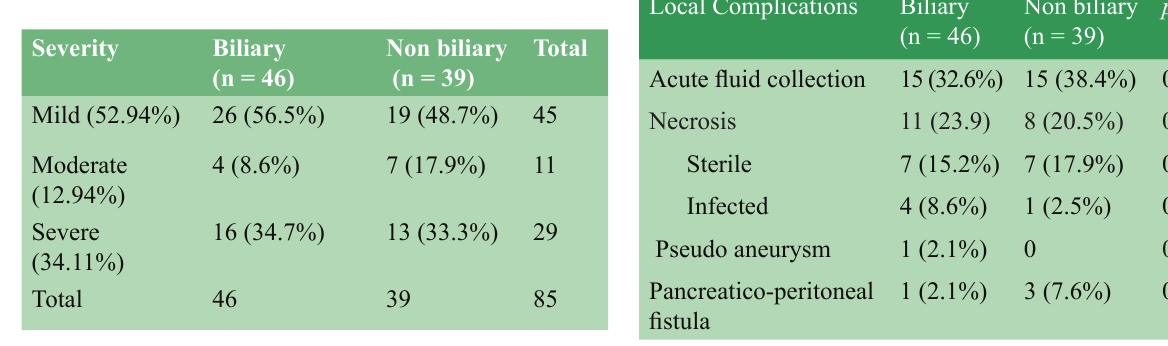
Table 3: Distribution of patients, according to severity